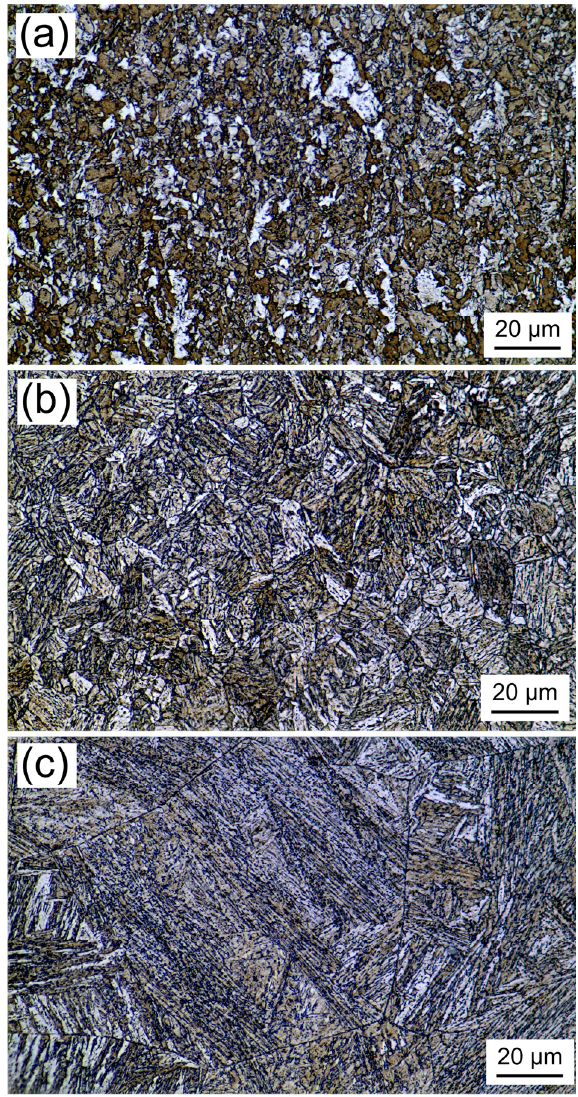
Figure 3. Distribution and morphology of the M-A (white) etched by LePera reagent with different austenitizing temperatures: ( a ) 860 °C; ( b ) 1000 °C; ( c ) 1250 °C.